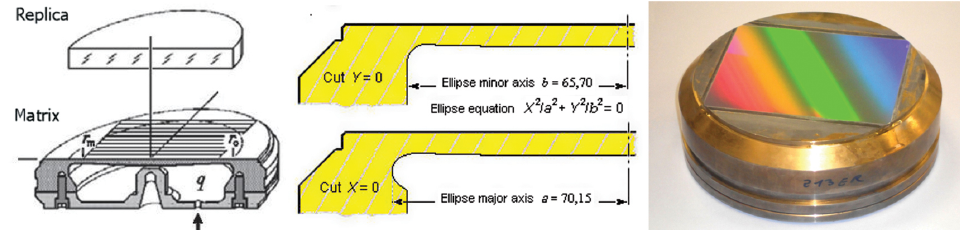
Figure 12: (Left) Active optics aspherization of gratings achieved by the double replication technique of a metal de- formable matrix. A quasi-constant thickness active zone is clamped – or built-in – to a rigid outer ring which is closed back- side for air pressure load control. (Center) For FIREBall, the whole deformable matrix is an axisymmetric piece expect for its inner built-in contour which is elliptical . (Right) View of the matrix with grating before second replication on glass ceramic